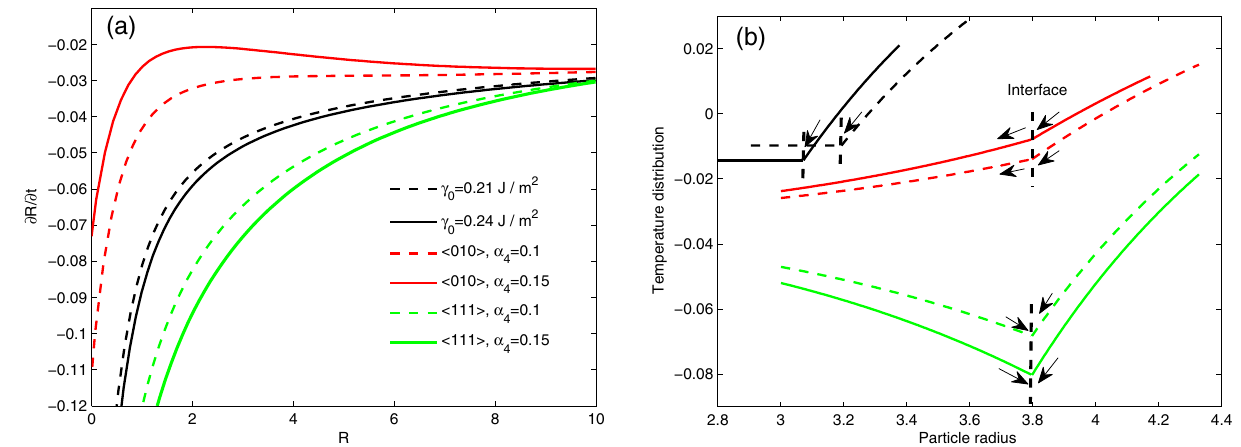
Figure 5. ( a ) Dimensionless dependence of the interface speed ∂ R /∂ t on the particle radius R under various surface energy values, plotted by the asymptotic solution (18). ( b ) Dimensionless temperature distributions in the solid and liquid phases near the interface (black dotted lines) corresponding to the value of surface energy in ( a ), plotted by the asymptotic solution (17). The temperatures of the solid and liquid phases are located on the left and right sides of the interface (vertical dashed lines), respectively. The arrows represent the heat flux